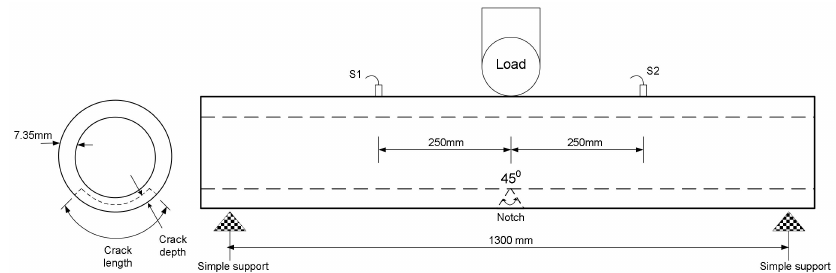
Figure 1. The bending test schematic